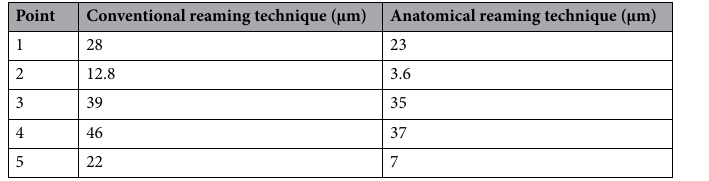
Table 3. Micromotion between the interfaces around the